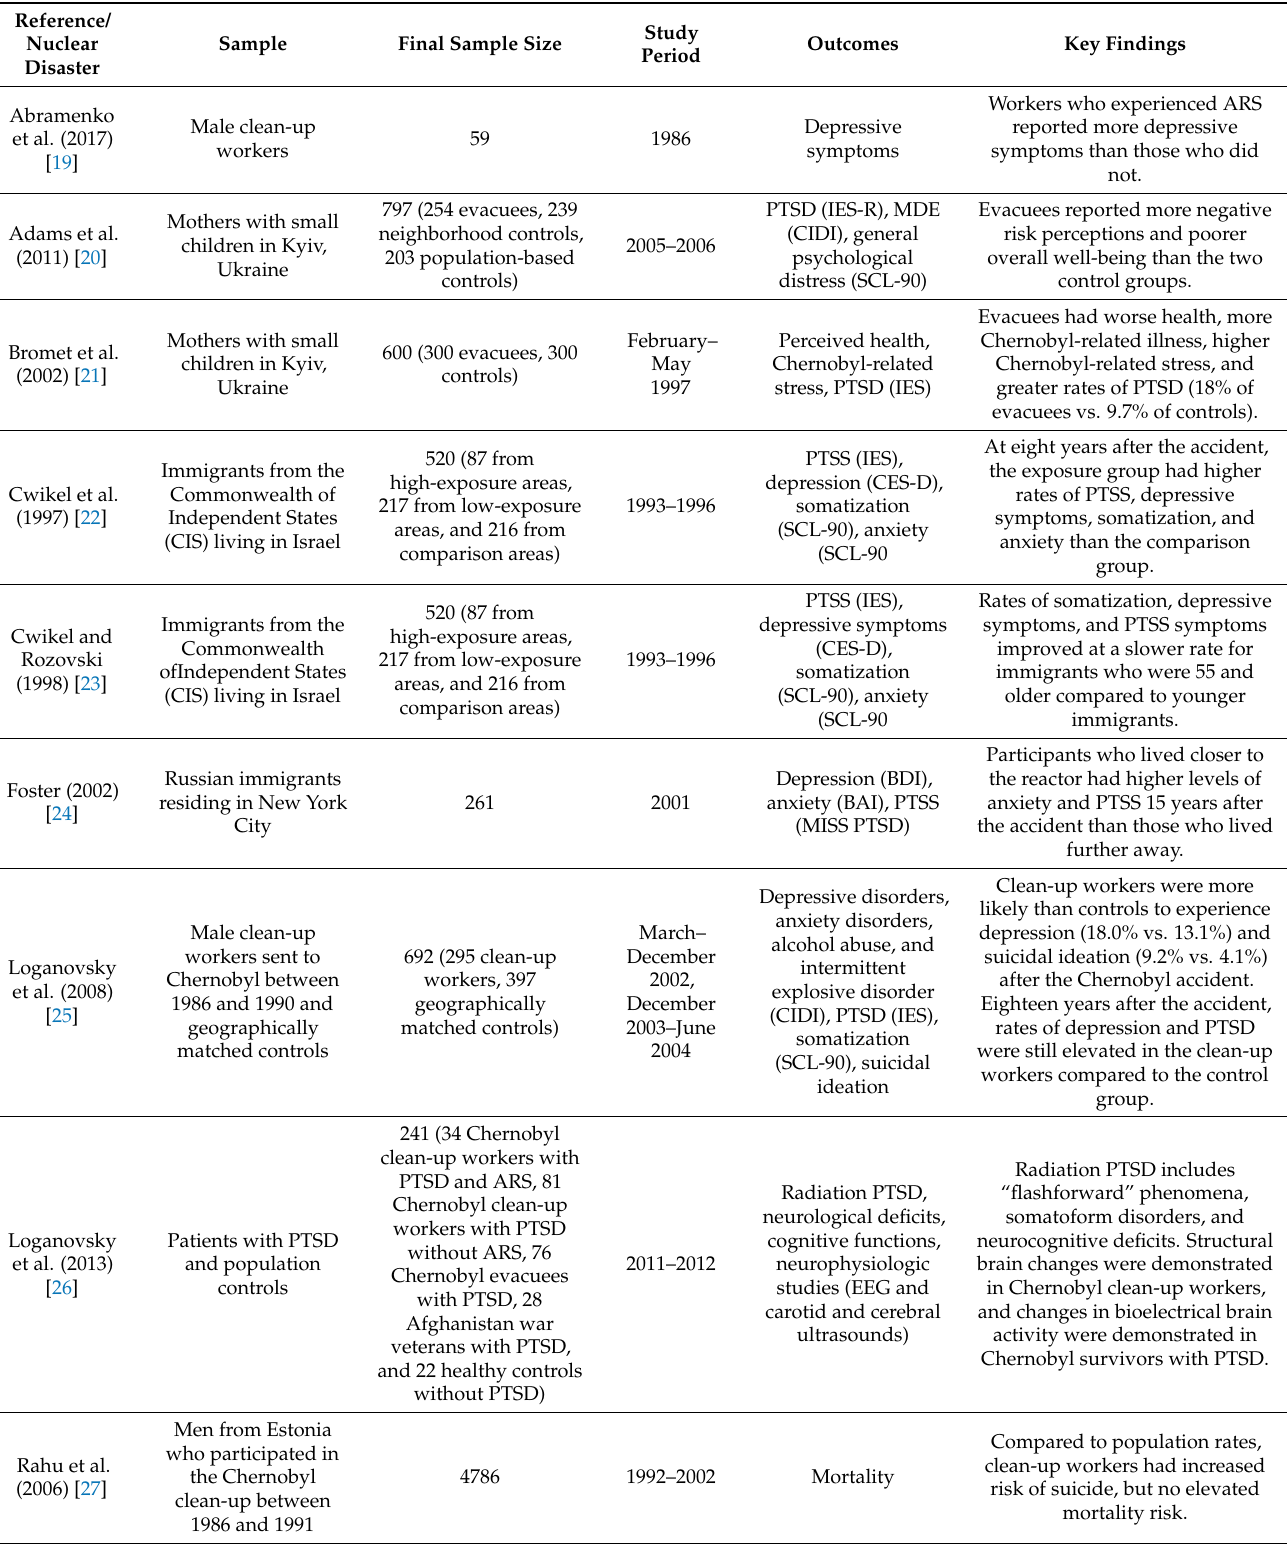
Table 2. Studies assessing psychological consequences of the Chernobyl nuclear